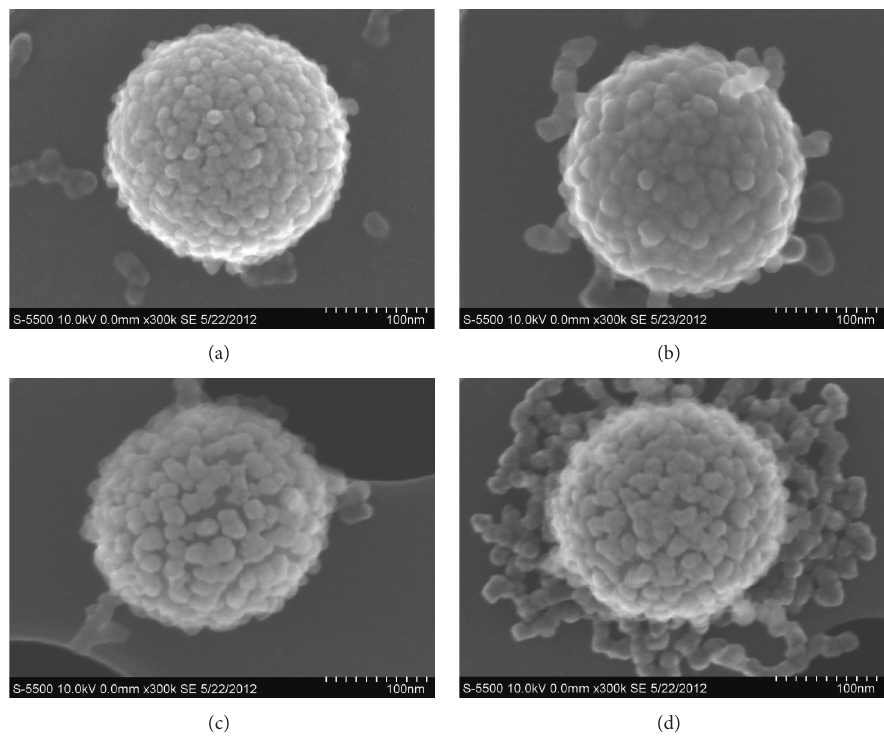
Figure 4: SEM images of (a) for Sample A, (b) for Sample B, (c) for Sample C, and (d) for Sample D. The PS template is within the spheres.